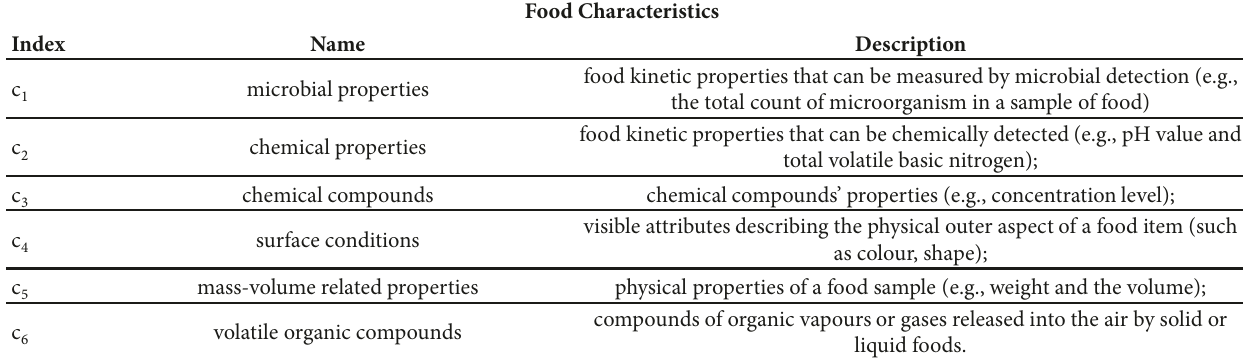
Table 2: The set C of food